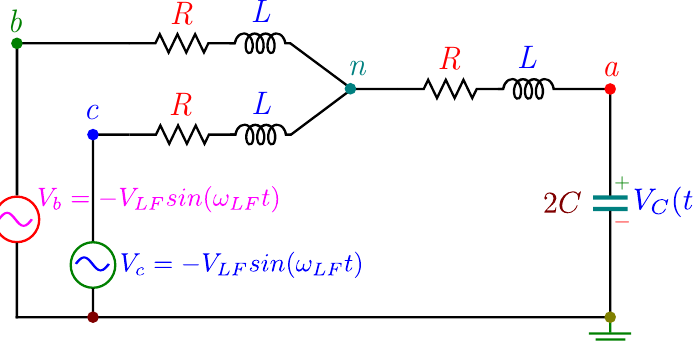
Figure 4. Electrical circuit of the zero angle LFS injection for FSTP inverter based PMSM